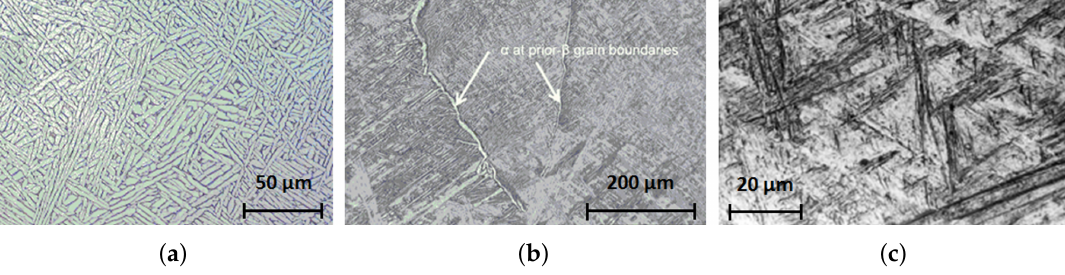
Figure 1: Ti6Al4V microstructures at room temperature. a) Widmanst(cid:228)tten alpha [12] b) Grain boundary alpha [12] c) Martensite [13] Figure 1. Ti6Al4V microstructures at room temperature. ( a ) Widmanstätten alpha [15]; ( b ) Grain boundary alpha [15]; ( c ) Martensite